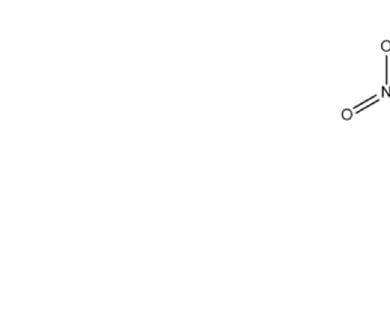
FIGURE 1 | The chemical structures of RDX and HMX.